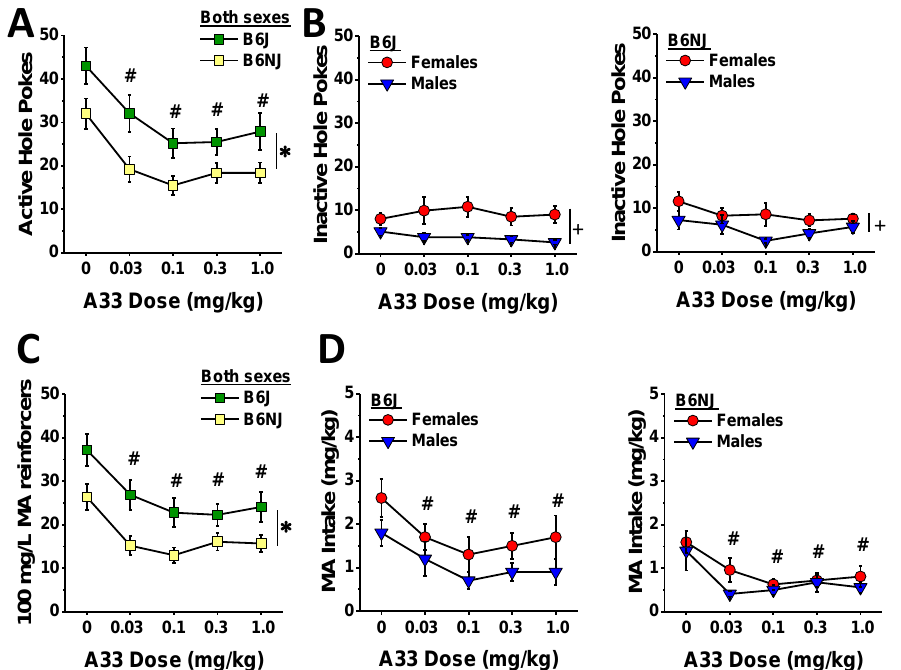
Figure 5. Summary of the effects of A33 pretreatment on established MA self-administration for a 100 mg/L MA reinforcer, highlighting the A33-induced reduction in the number of nose pokes in the active, MA-reinforced hole ( A ) but no A33 effect on nose poking in the inactive, non-reinforced hole ( B ) in B6J (left) and B6NJ mice (right). A33 also reduced the number of reinforcers earned, irrespective of sex ( C ) and lowered MA intake ( D ) in both B6J (left) and B6NJ (right) mice. The data represent the mean ± SEM of 12 mice/sex/substrain. * represents a main substrain effect; + represents a significant sex effect, p < 0.05; # p < 0.05 vs. 0 mg/kg A33 for both substrains/sexes.